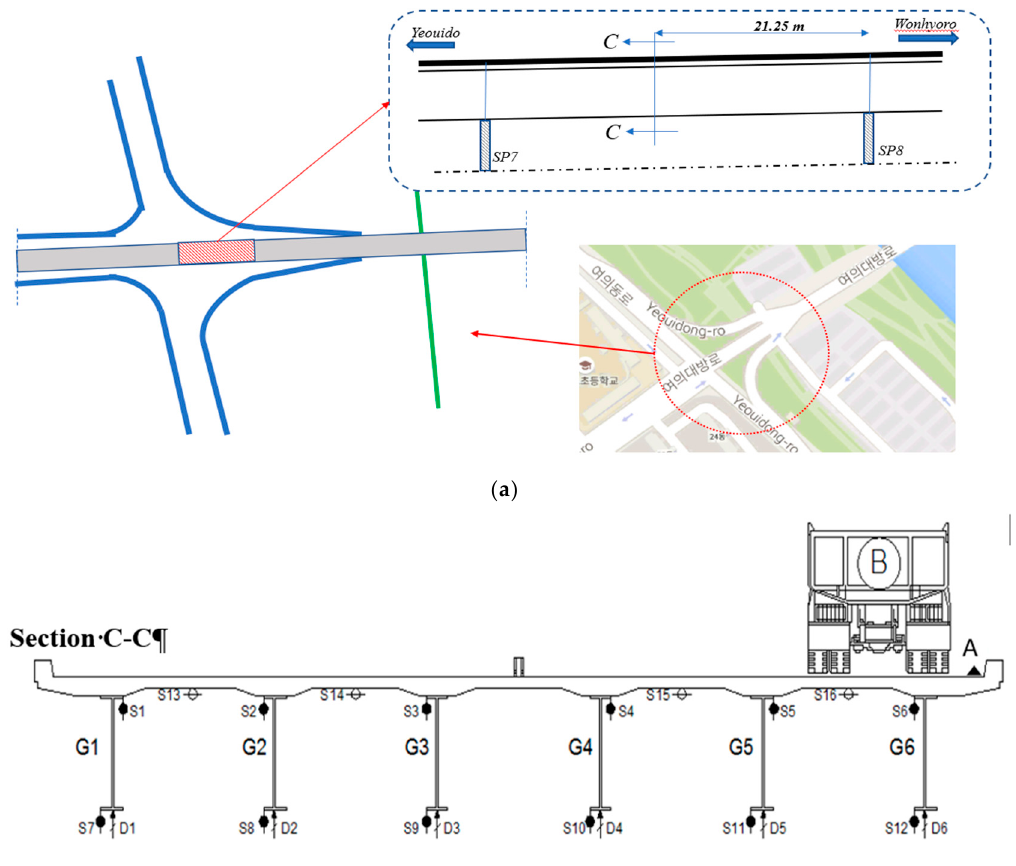
Figure 3. The WonHyo bridge ( a ) studied the span position and elevation and ( b ) the cross section, load case and monitoring system (G=girder, S=strain, D=displacement, A=accelerometer).